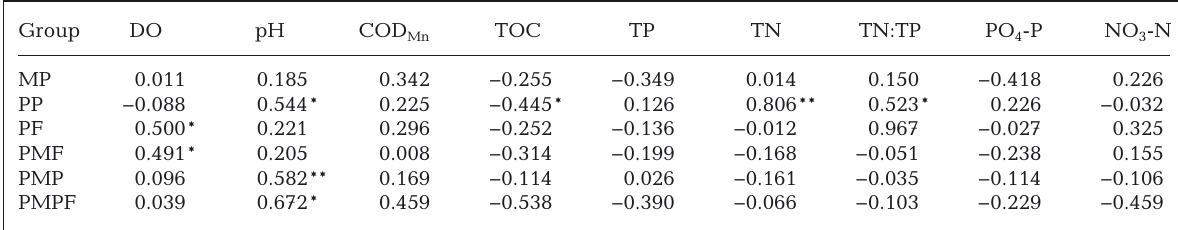
Table 3. Correlation coefficients between chlorophyll a and water quality impact factors. Significant differences are indicated as *p < 0.05, **p < 0.01. Treatment groups are defined in Table 1; water quality parameters are defined in Table